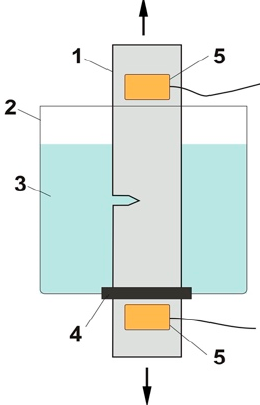
Figure 2. Scheme of holding the specimen during the measurement in corrosive conditions. 1— specimen, 2—glass vessel, 3—electrolyte, 4—gasket, and 5—electrodes.